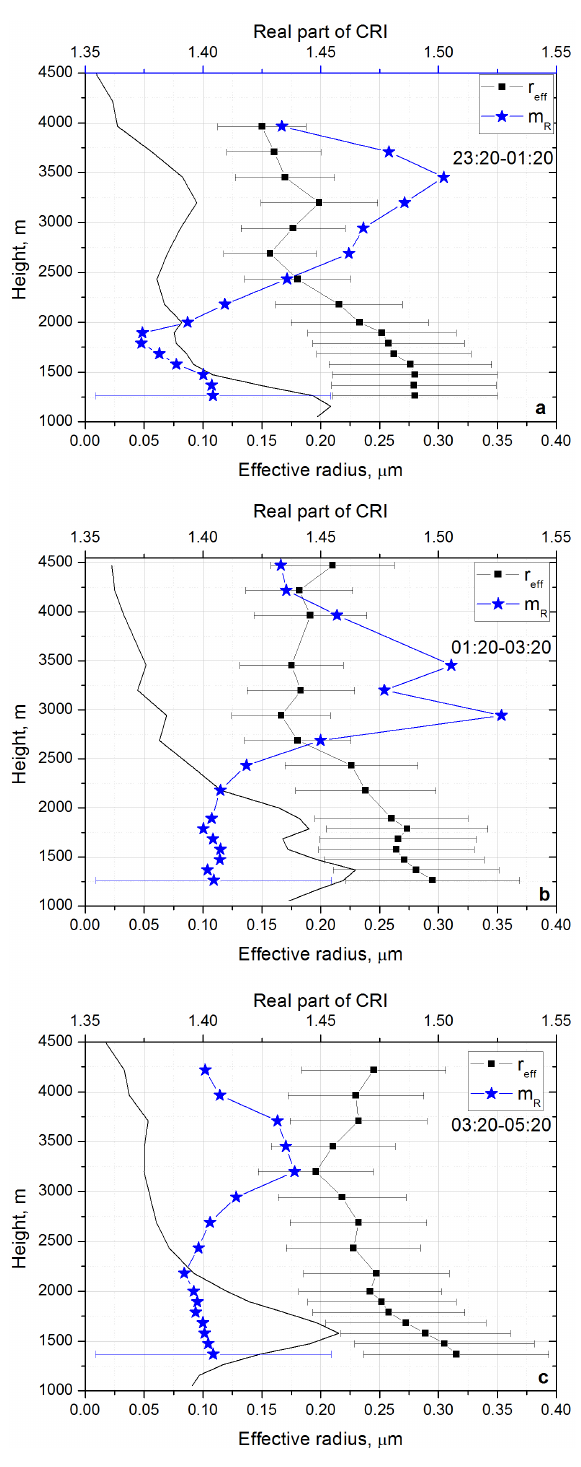
Figure 12. Effective radius (stars) and the real part of the refractive index (squares) derived from 3 β + 2 α measurements on 27–28 Au- gust for the same three time intervals as in Fig. 7. Solid lines show the profiles of backscattering coefficients at 355nm without scale.